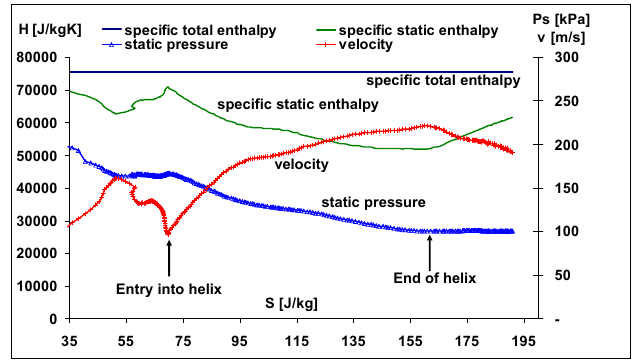
Figure 6. Variation of the Enthalpies, static pressure and velocity in the windback seal as a function of the entropy at a mass flow of 12 g/s.